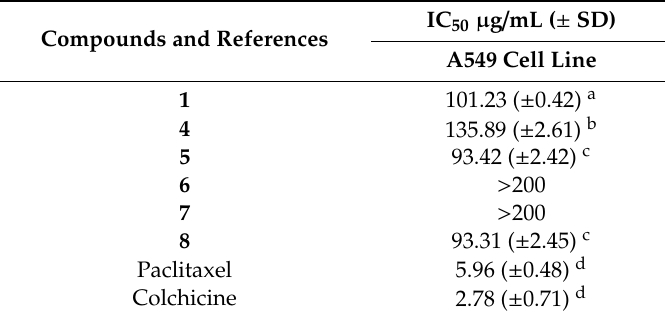
Table 3. Antitumor activity of the synthesized compounds 1 , 4 – 8 .